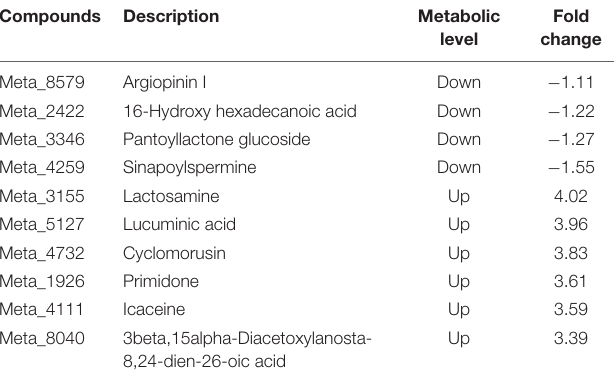
TABLE 8 | Ten differential metabolites detected in the Ri + Pf + Th treatment compared with Fo treatment in tomato